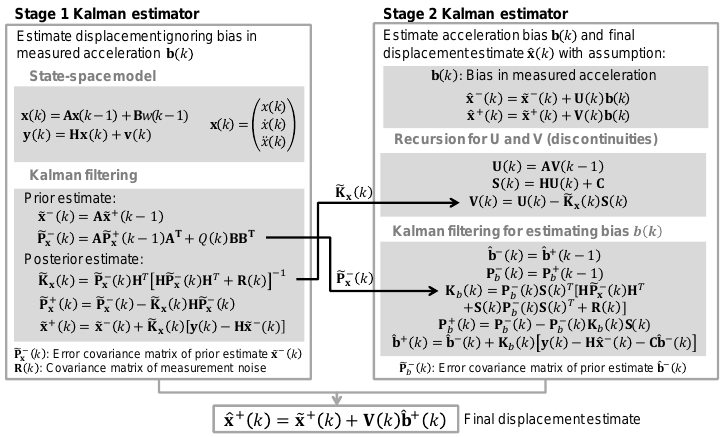
Figure 7. Overview of two-stage Kalman filter algorithm.